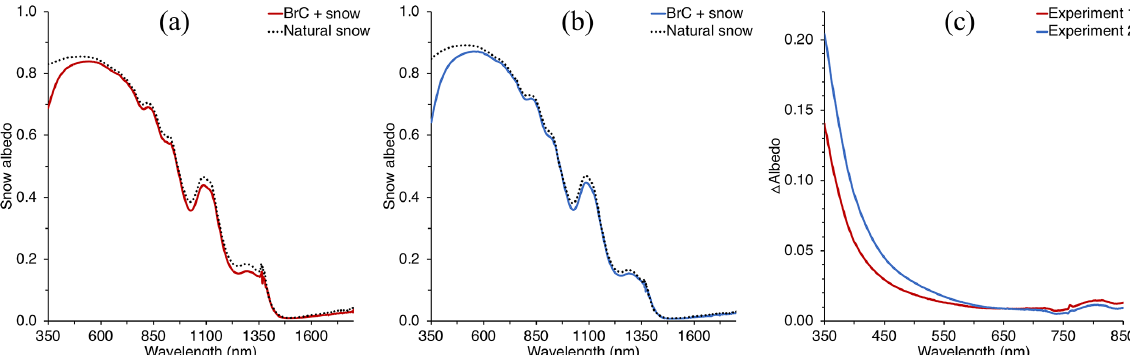
Figure 3. Panels (a) and (b) show the measured spectral snow albedo of the deposition area for Experiment 1 and Experiment 2, respectively, along with an adjacent area of natural snow. Panel (c) indicates the difference between the spectral albedo of the snow with and without deposited BrC in the UV–Vis wavelength range, indicating a strong wavelength dependence of absorption by impurities deposited on the